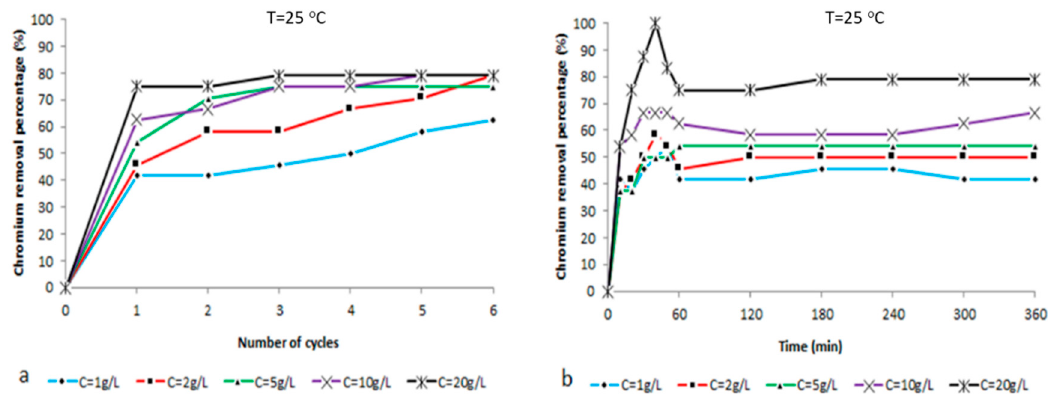
Figure 11. ( a ) Chromium removal percentage vs number of treatment cycles with zeolite X at T = 25 °C and pH = 5.5 for the ratios: (i) 2:1 g/L, (ii) 2:2 g/L, (iii) 2:5 g/L, (iv) 2:10 g/L and (v) 2:20 g/L potassium dichromate:zeolite X. ( b ) Chromium removal percentage vs time (10 min for the first treatment hour and then every 1 h) at T = 25 ° C and pH = 5.5 for the ratios: (i) 2:1 g/L, (ii) 2:2 g/L, (iii) 2:5 g/L, (iv) 2:10 g/L and (v) 2:20 g/L potassium dichromate:zeolite X .